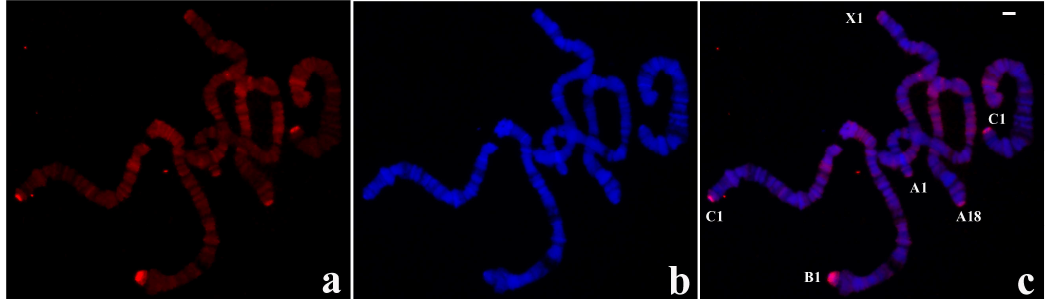
Figure 3. ( a ) Localization of the probe (red signal) synthesized with DNA from a microdissected B-1 chromosome end of R. americana in polytene chromosomes of R. americana. ( b ) The corresponding image stained with DAPI (blue signal) and ( c ) the merged signals. Non centromeric chromosome ends labelled by the probe were identified. Bar = 20 µ m.